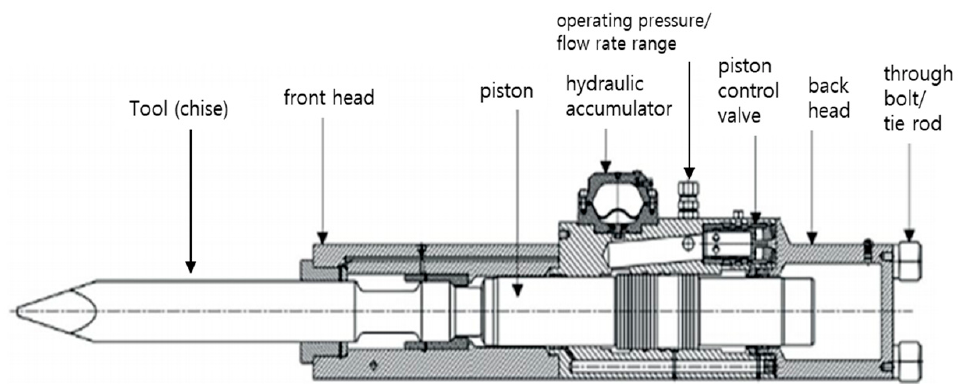
Figure 1. The general structure of a hydraulic breaker.